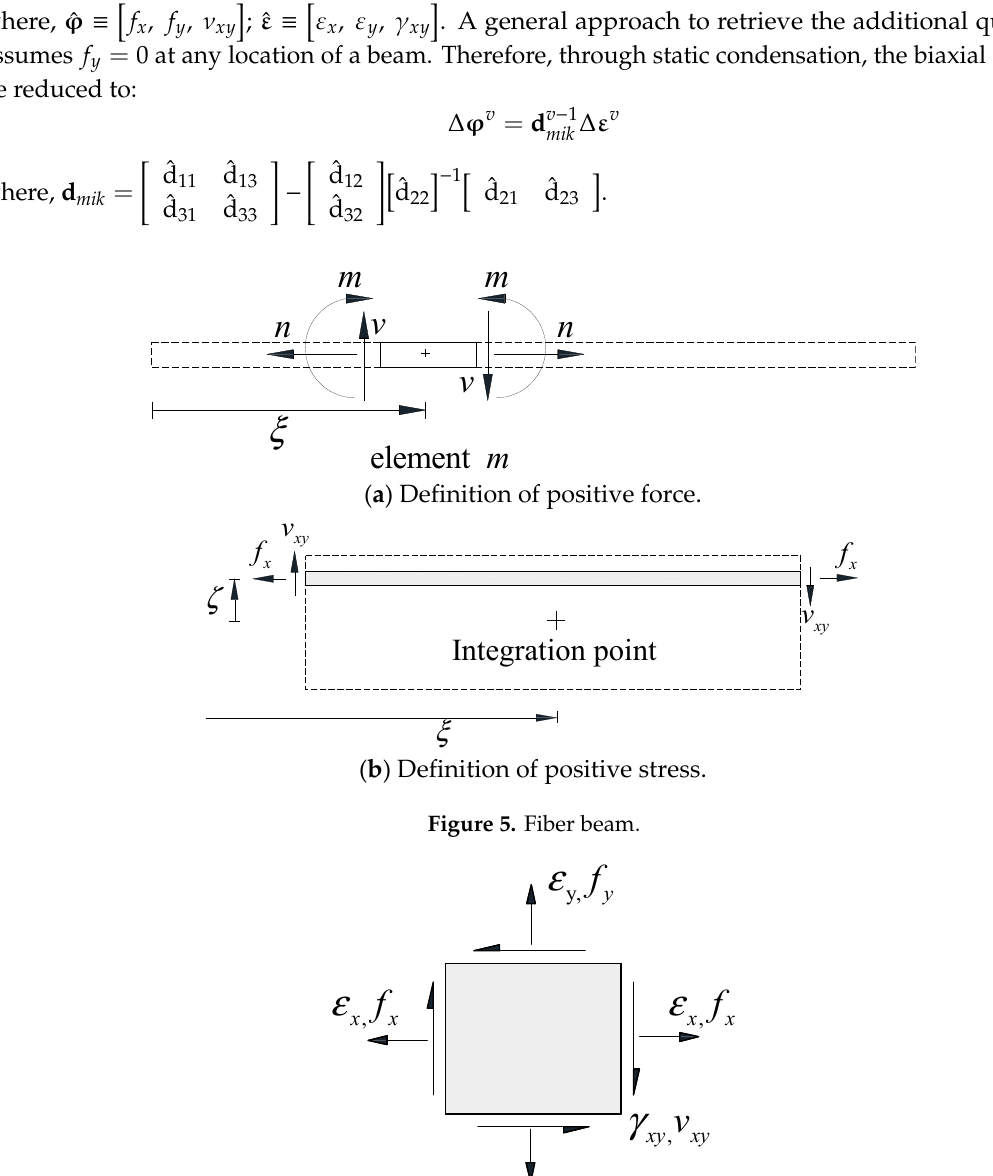
Figure 6. Definition of biaxial state of an infinitesimal element.